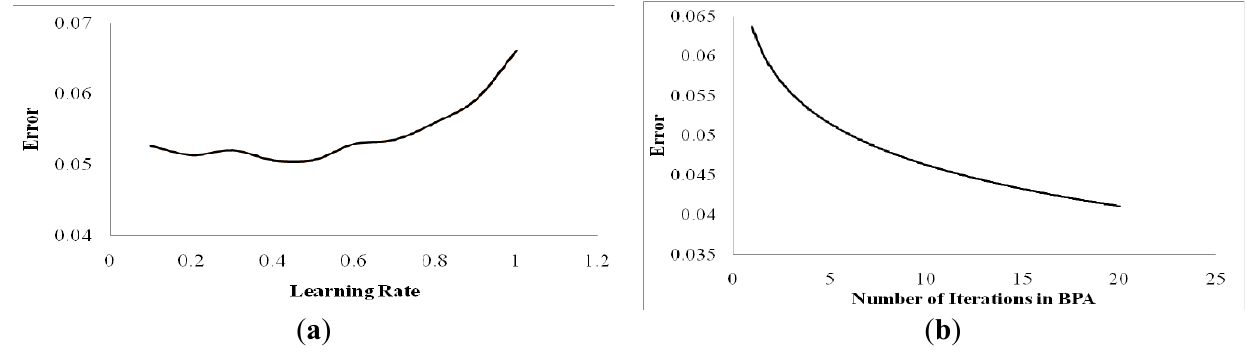
Figure 7. ( a ) Error vs. Learning Rate. ( b ) Error vs. Number of iterations in